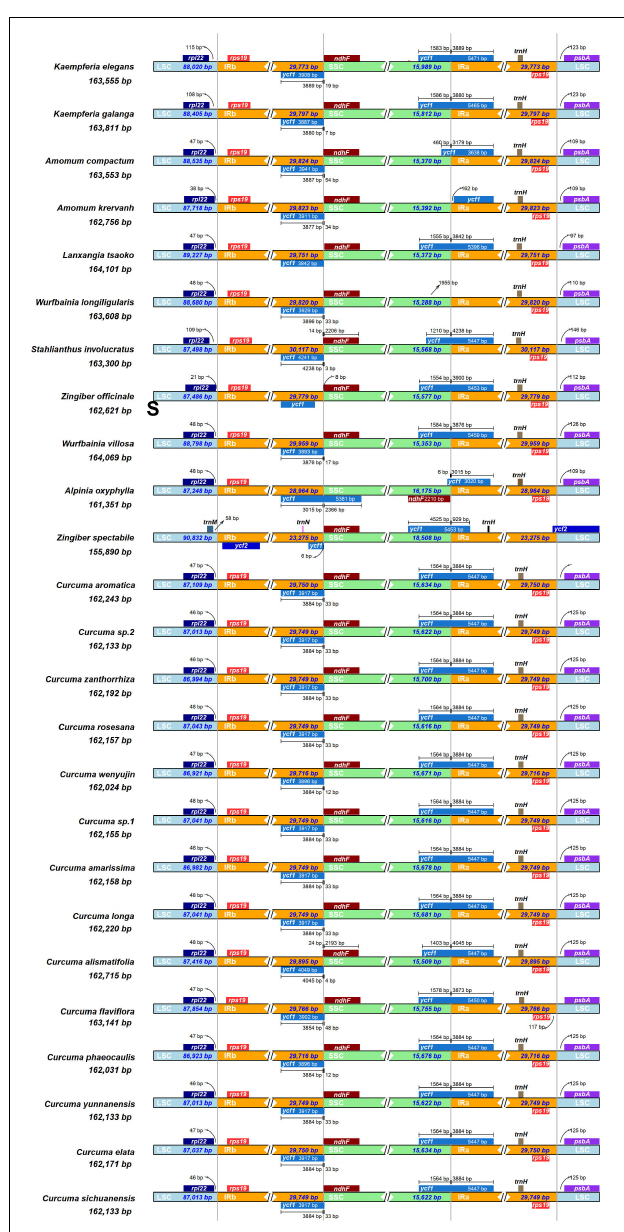
FIGURE 3 | Comparison of the junctions between the LSC, SSC and IR regions among 25 Zingiberaceae chloroplast genome. The figure is not to scale LSC, SSC, and